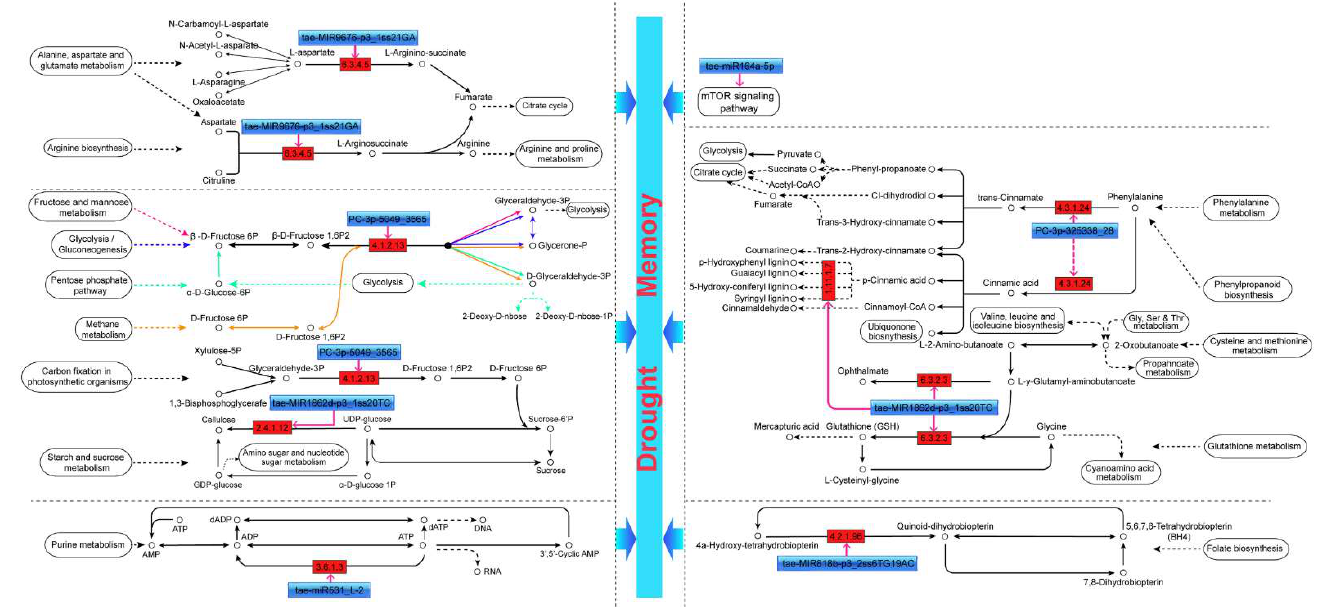
Figure 6. A proposed regulatory mechanism involving the differentially expressed miRNAs and their target genes in wheat drought memory. Targets of eight miRNAs were enriched to fifteen pathways that might be crucial to drought memory.